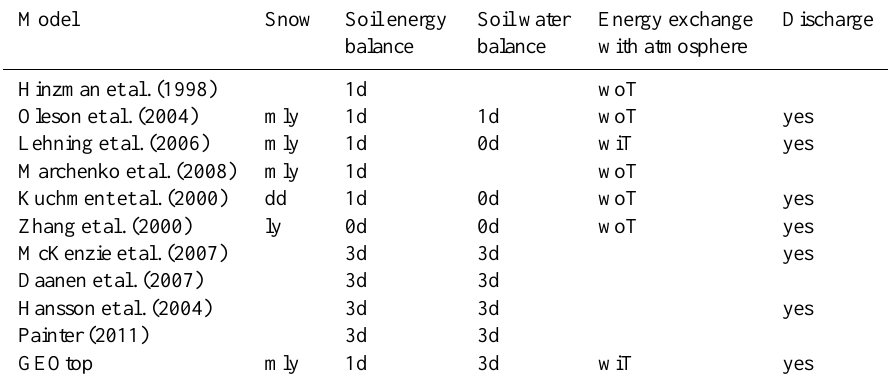
Table 1. Overview of existing simulators dealing with soil-freezing processes. Abbreviations: in the snow column: dd = degree day factor, ly = one-layer energy balance, mly = multilayer energy balance; in the soil energy and water balance columns: 0d = simplified, 1d = one- dimensional (vertical) solution of the heat or Richards equation, 3d = three-dimensional solution; in the column about the energy exchange with atmosphere: wiT = with complex topography, woT = without complex topography.